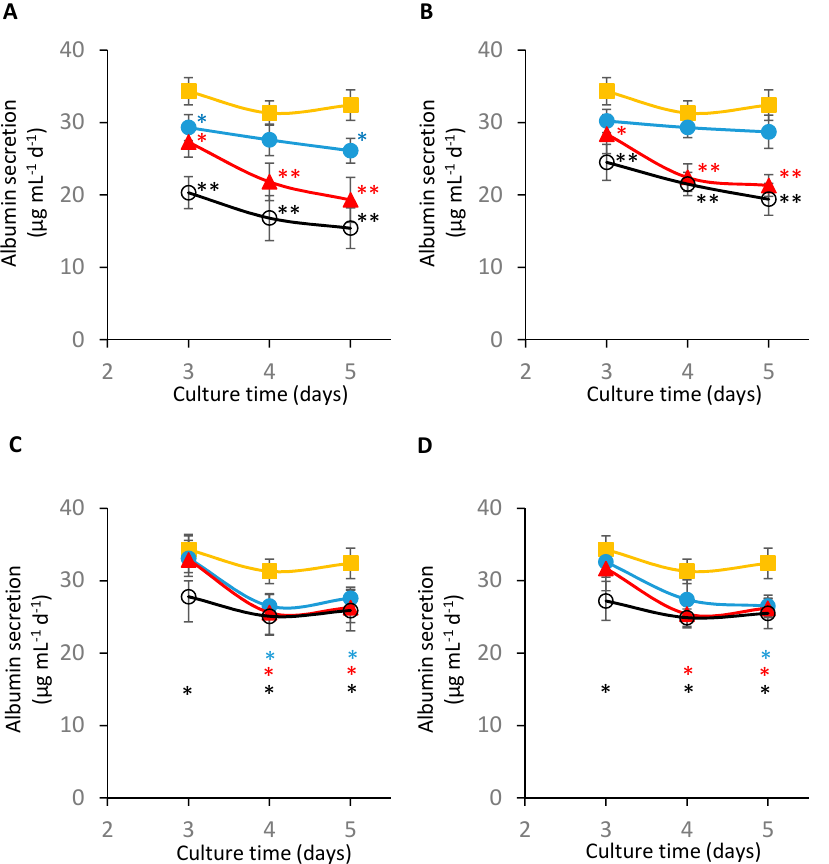
Figure 6. Time course of Albumin secretion of hepatocyte–endothelial cell heterospheroids labeled with polysaccharide magnetic iron oxide nanoparticles. The type of nanoparticle: ( A ) TMADM; ( B ) EADM; ( C ) ATDM; ( D ) CMDM. The heterospheroids were incubated for 2 d at 37 °C. After 48 h of cell culture, the heterospheroids were then incubated with various nanoparticles (0, 15, 30, and 60 μ g-Fe/mL) for 24 h at 37 °C. The addition conditions of various nanoparticle: control group (non-labeled heterospheroids, 0 μ g-Fe/mL) (closed orange squares, █ ); 15 μ g-Fe/mL (closed sky-blue circles, ● ); 30 μ g-Fe/mL (closed red triangles, ▲ ); 60 μ g-Fe/mL (open circles, 〇 ). The albumin secretion by heterospheroids on days 3, 4, and 5 was measured with ELISA. The data shown represent the means and SD of three independent experiments. p -values are presented. Welch’s t -tests were used to compare albumin secretion of the control group (non-labeled heterospheroids, 0 μ g-Fe/mL) vs. the labeled groups. No mark = no significance, * p < 0.05, ** p < 0.01.